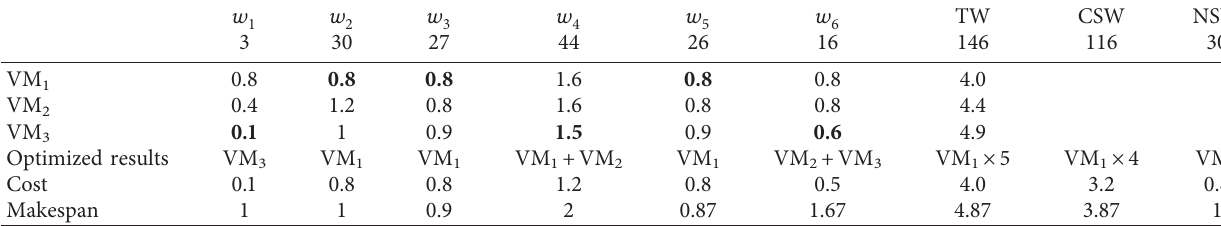
Table 3: The results of provisioning sample VMs to sample